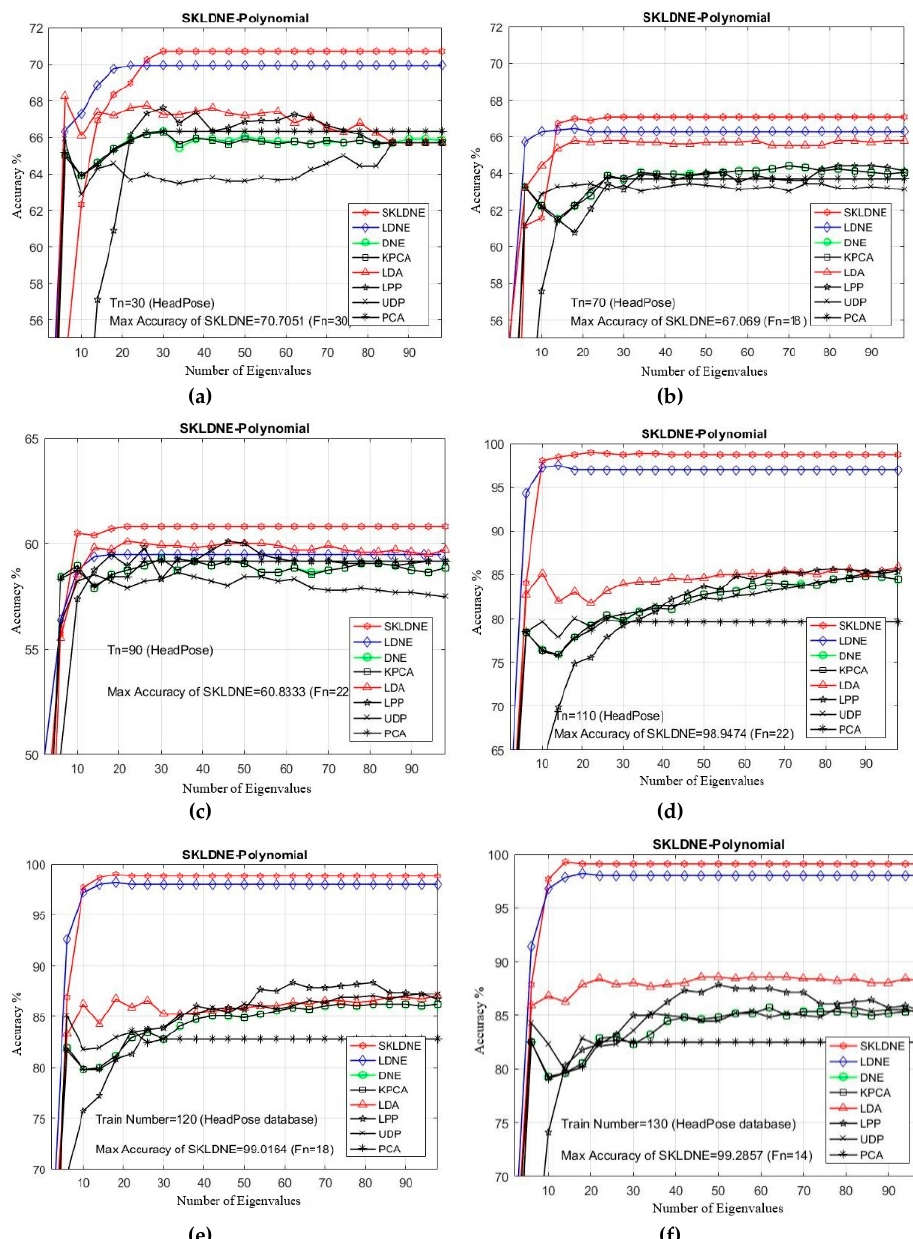
Figure 9. ( a–f ) Comparative recognition results changing the dimensionality of the transformation matrix for each given training number Tn in each dataset (Head Pose